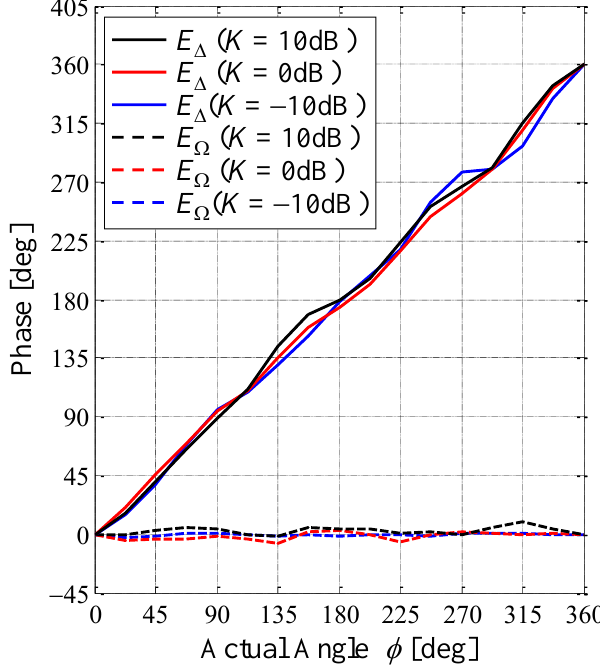
Figure 21. Phase characteristics vs. angle of the incoming wave.